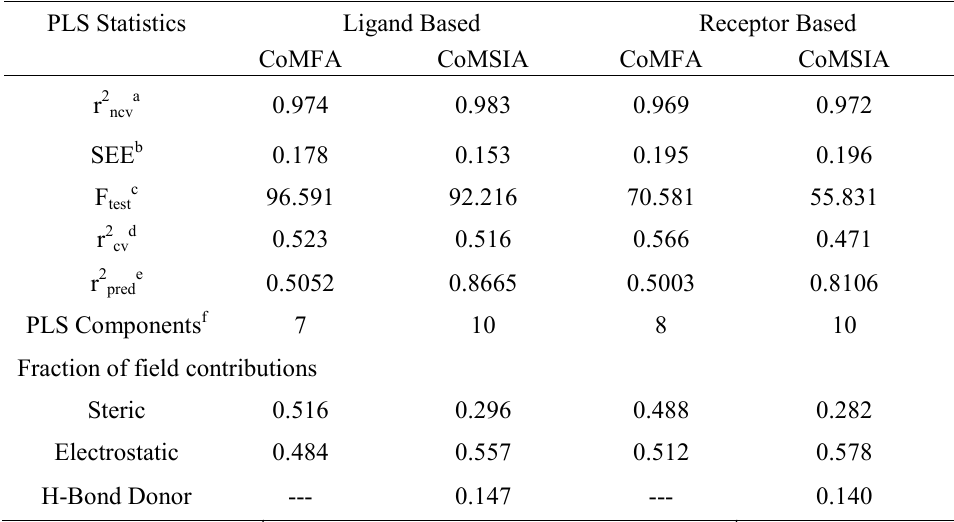
Table 2. Summary of CoMFA and CoMSIA